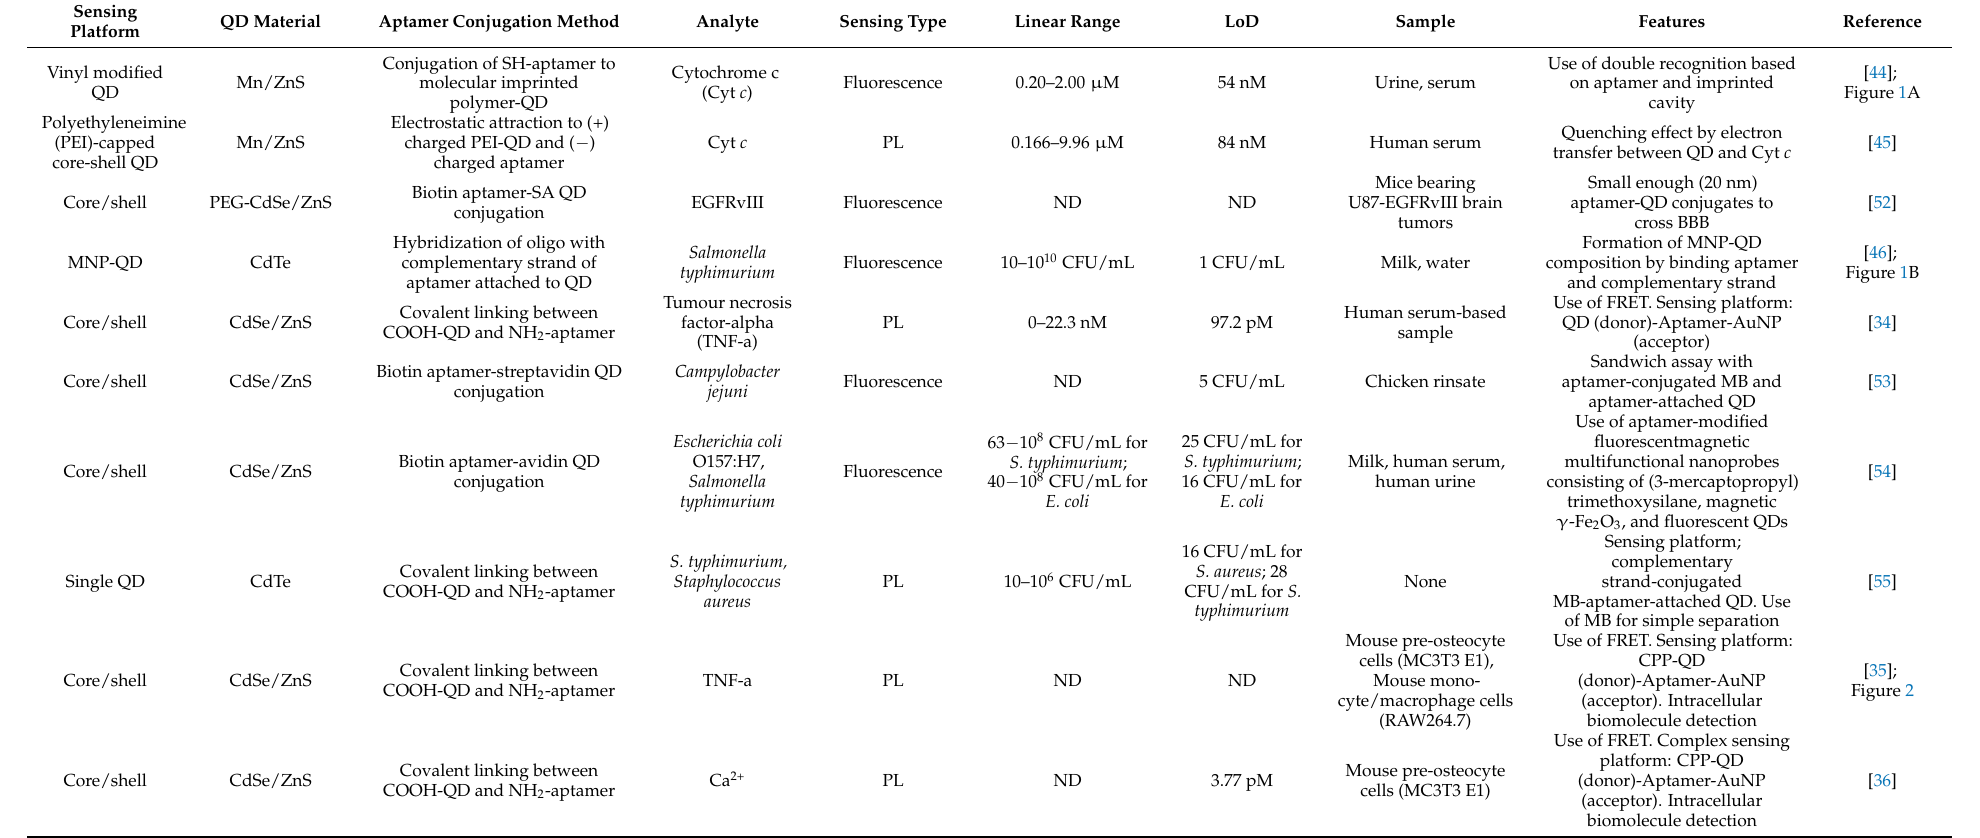
Table 1. Examples of aptamer-based QD biosensors for detection of various molecules a